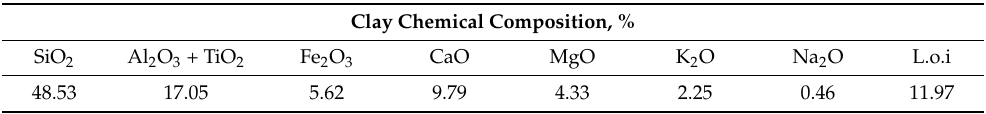
Table 1. Chemical composition of the studied clay. Clay Chemical Composition,